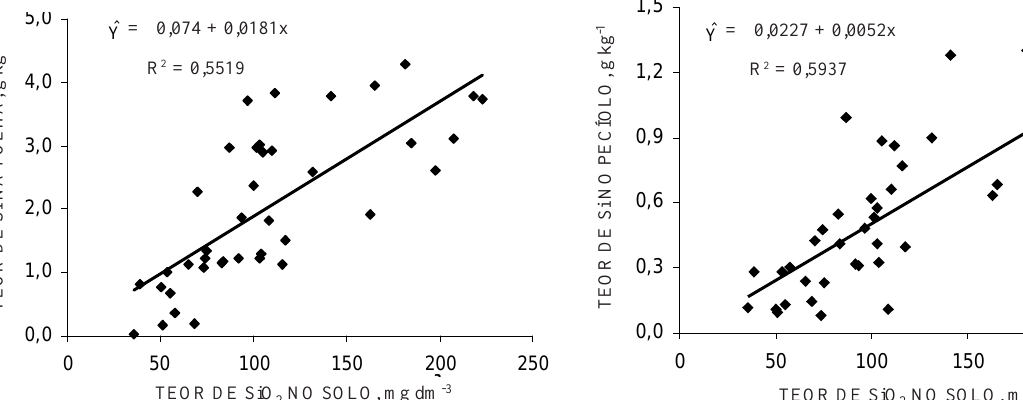
Figura 2. Correlação entre silício “disponível” no solo e teor de silício dos pecíolos do